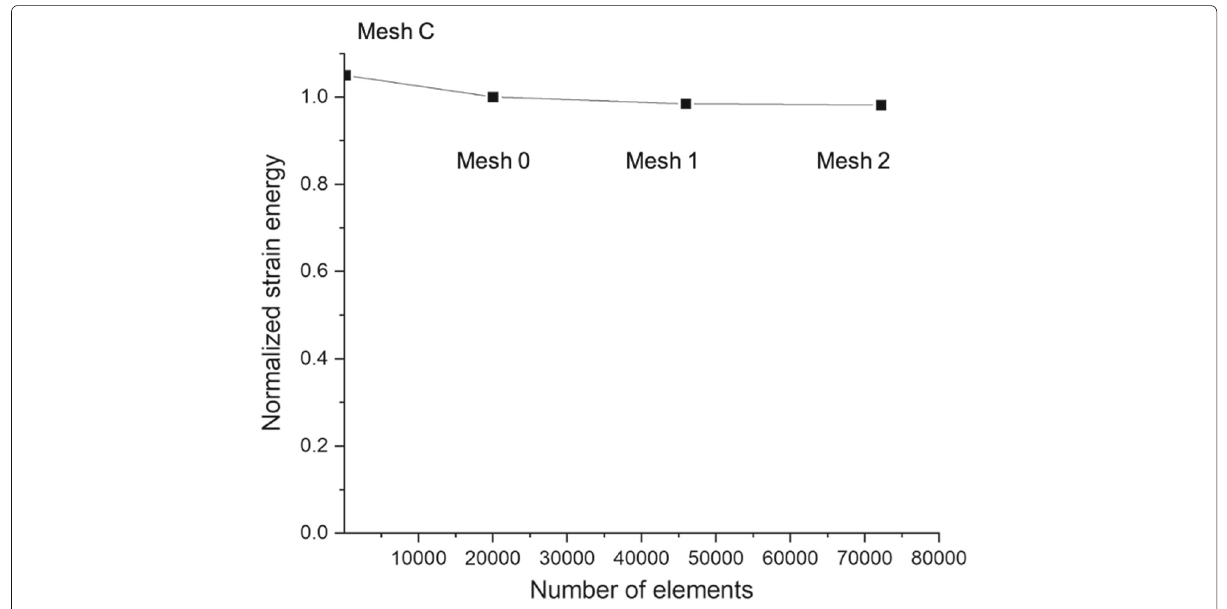
Fig. 12 Total strain energy versus the number of elements